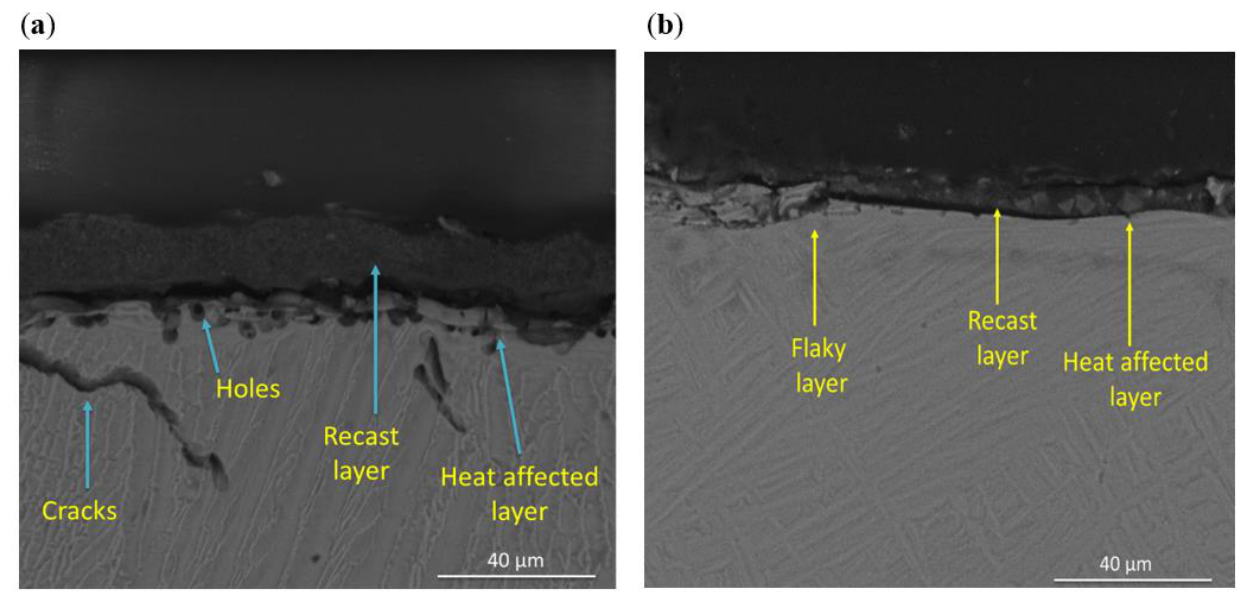
Figure 11. Typical cross-sectional view of surface machined by wire EDM: ( a ) Ti-6Al-4V and ( b ) Ti-6Al-7Nb.